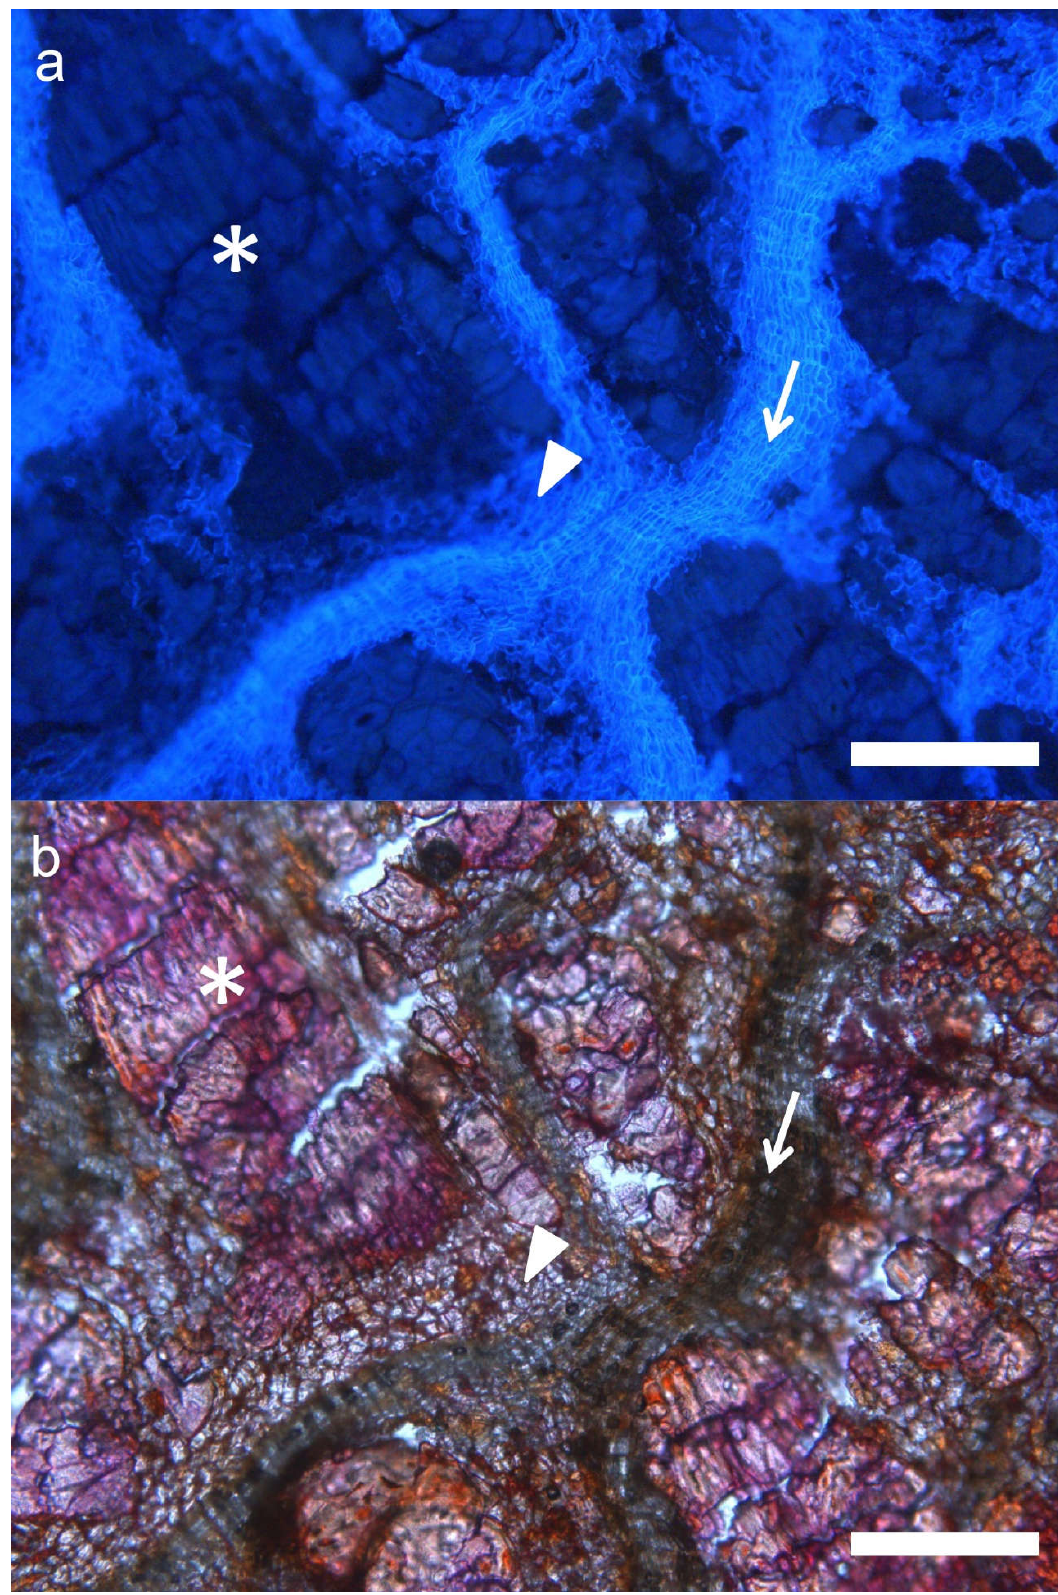
Figure 6. Cross section of the bark of a hybrid tree under UV ( a ) and visible light ( b ). Periderms (arrow), a large proportion of schlerenchymatic nodules (asterisk), and a lower proportion of suberized inactive phloem (arrowhead) can be appreciated. Bar: 100 μm.